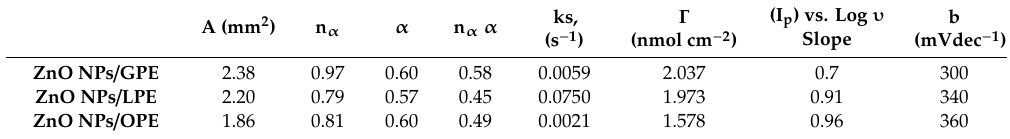
Table 6. Summary of electrochemical parameters of SPC / ZnO NPs / CPE